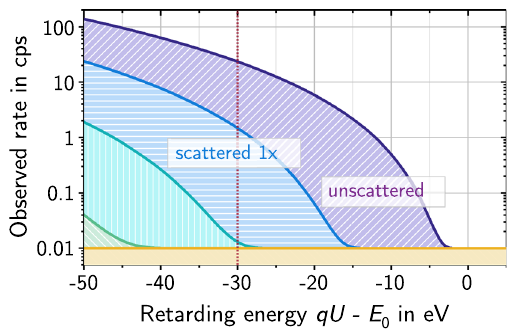
Fig. 18 Statistical, systematic and total 1 σ uncertainty of m 2 ν on the left vertical axis, and 90%C.L. sensitivities of m ν on the right vertical axis, plotted over the effective measuring time. Thirty-six live months (3 live years) correspond to 5 calendar years of KATRIN operation